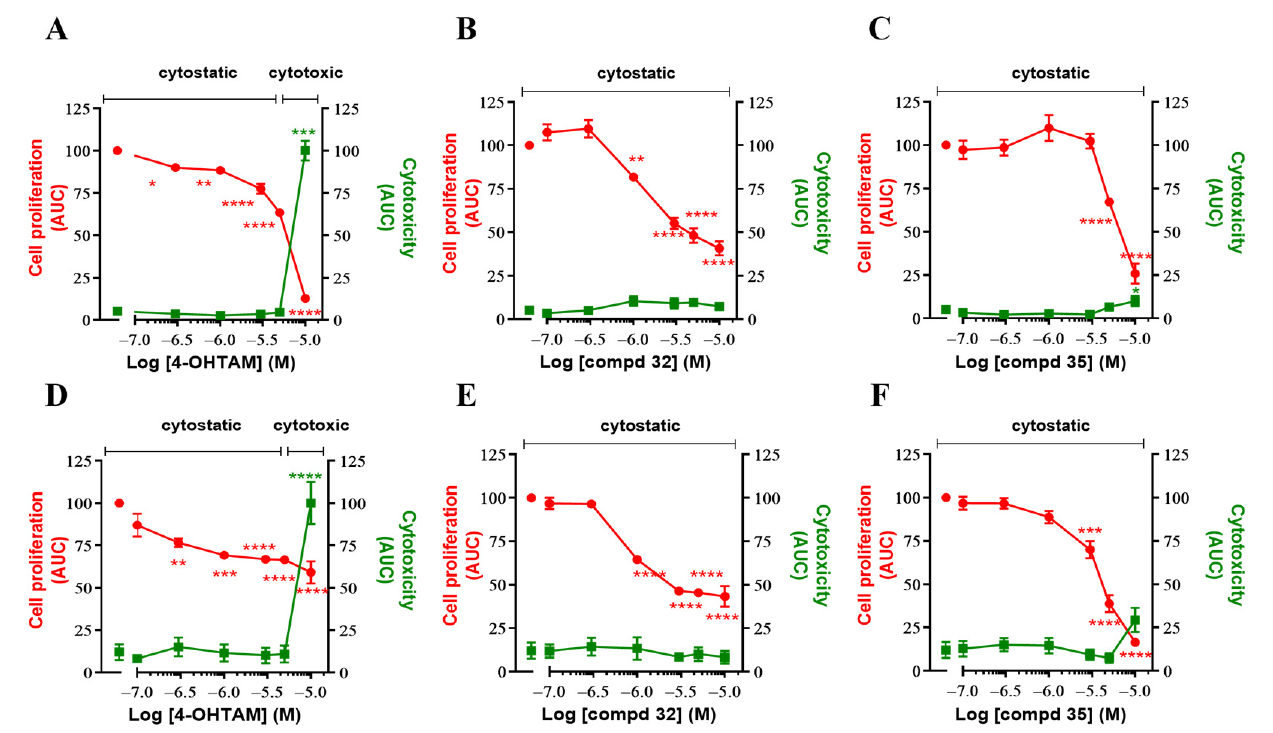
Figure 6. 5-Hydroxy-2 H -pyrrol-2-ones 32 and 35 reduce cell growth of human ER+ breast cancer cells with low cytotoxicity. ( A – C ) T47D and ( D – F ) MCF-7 cells were seeded in complete estrogenic media (10%FBS) and treated with vehicle (VEH, 0.05% DMSO) or different doses of compounds (0.01–10 µM) for 5 days. Data represent the area under the curve (AUC) by compounds dose in terms of proliferation in phase contrast (left Y -axis) and green-fluorescent cytotoxicity (right Y -axis). The mean ± SEM values are represented for each dose, comparing proliferation with respect to the maximum cell growth of VEH cells, and the maximum cytotoxicity with respect to the effect caused by the highest dose of 4-OHTAM. Statistical significance was assessed using one-way ANOVA with the Bonferroni post hoc test. * p < 0.05, ** p < 0.01, *** p < 0.001, **** p < 0.0001 vs. VEH-treated cells. Since cell spheroids represent tumor cell biology better than 2D cultured cells [54], the effects of compounds 32 and 35 on the growth and viability of ER+ BC cell spheroids were monitored by sequential real-time microphotographs for 8 days. Remarkably, both